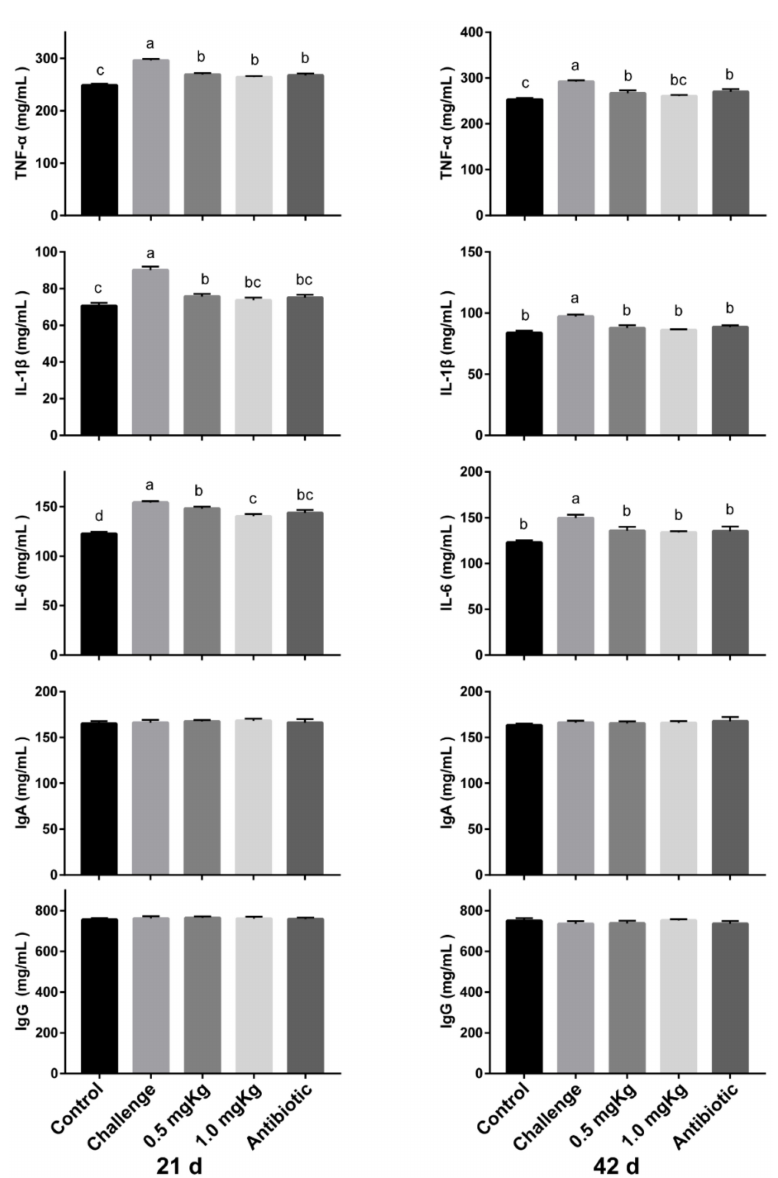
Figure 3. E ff ects of MccJ25 on immunomodulatory factors concentration in the serum on day 21 and day 42. Bars represent means ± SEM for 12 broilers per treatment. Bars with di ff erent letters di ff er significantly ( p <